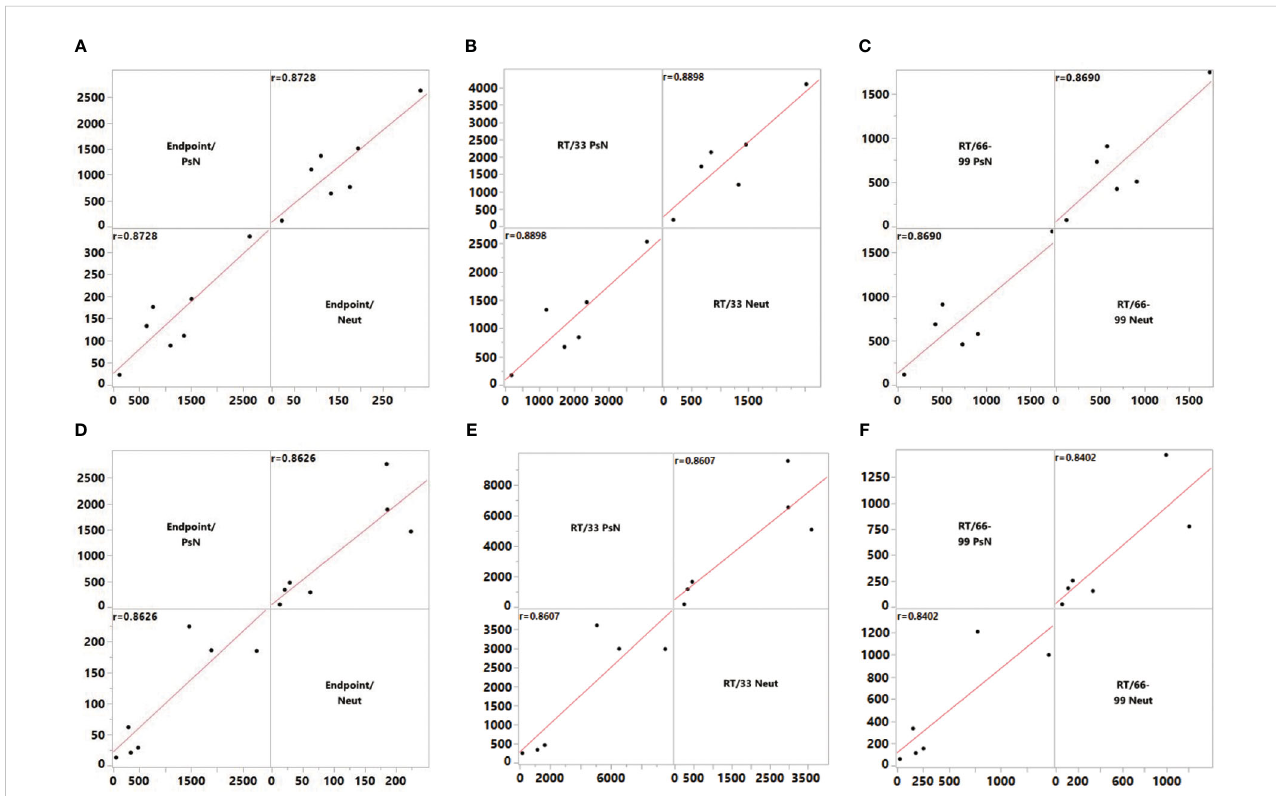
FIGURE 3 Correlation of endpoint titer and RT/33 and RT/66 – 99 between the pseudovirus neutralization assay (PsN) and live virus neutralization assay (Neut) methods. (A) Endpoint titer, wild-type (WT) strain, (B) Titers relative to 33, WT strain, (C) Titers relative to 66 – 99, WT strain, (D) Endpoint titer, Delta Variant, (E) Titers relative to 33, Delta Variant, (F) Titers relative to 66 – 99, Delta Variant. To assess the level of agreement between the PsN and Neut methods, correlations were estimated using the Row-wise method. Correlation coef fi cients were calculated using the endpoint titer and the titer relative to samples 33 and 66 –